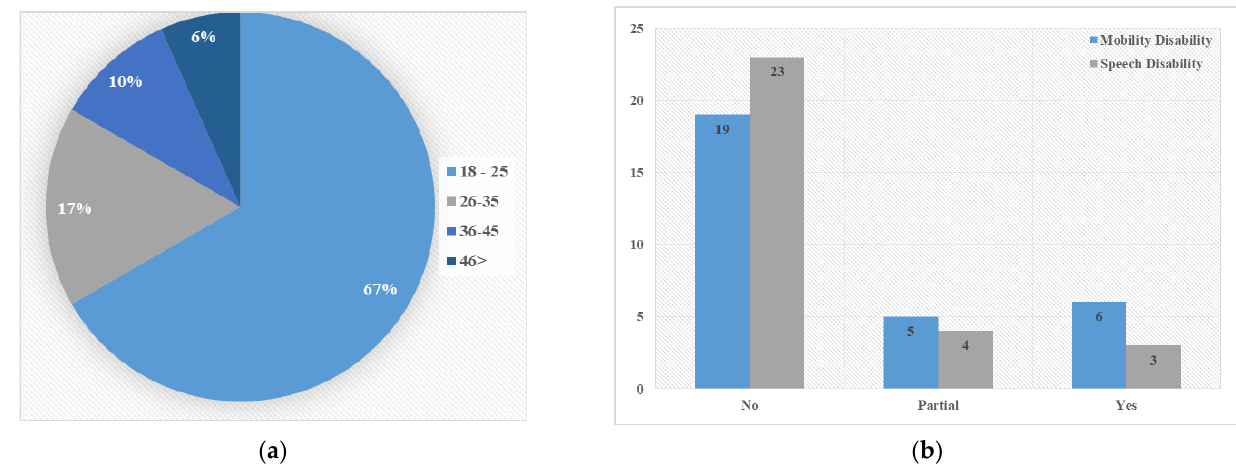
Figure 12. Participant demographics. ( a ) Age distribution; ( b ) Disability distribution.